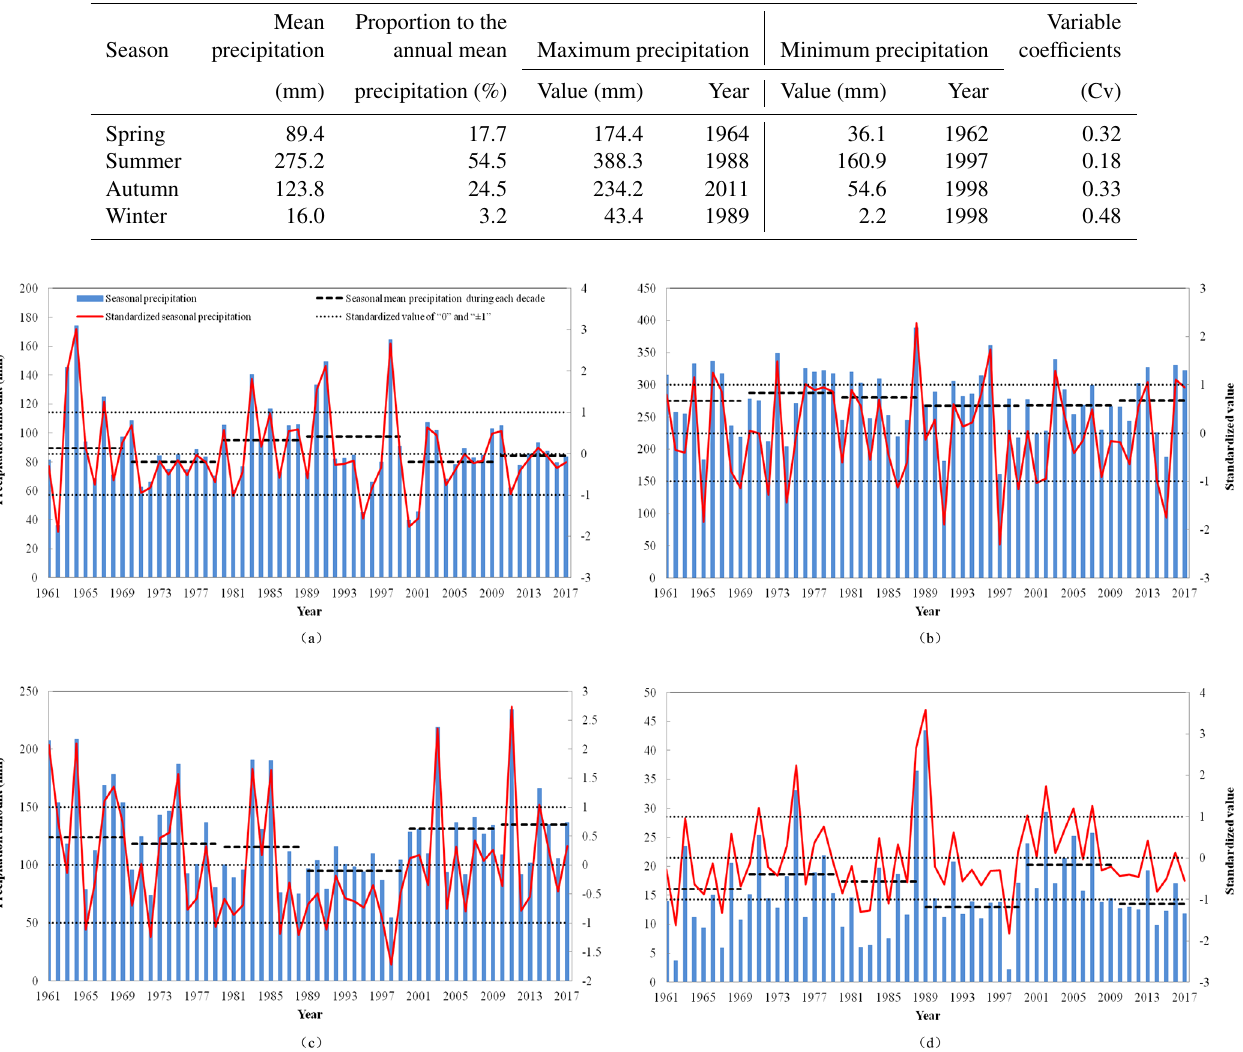
Figure 1. Time series of the spring (a) , summer (b) , autumn (c) and winter (d) precipitation in the Yellow River